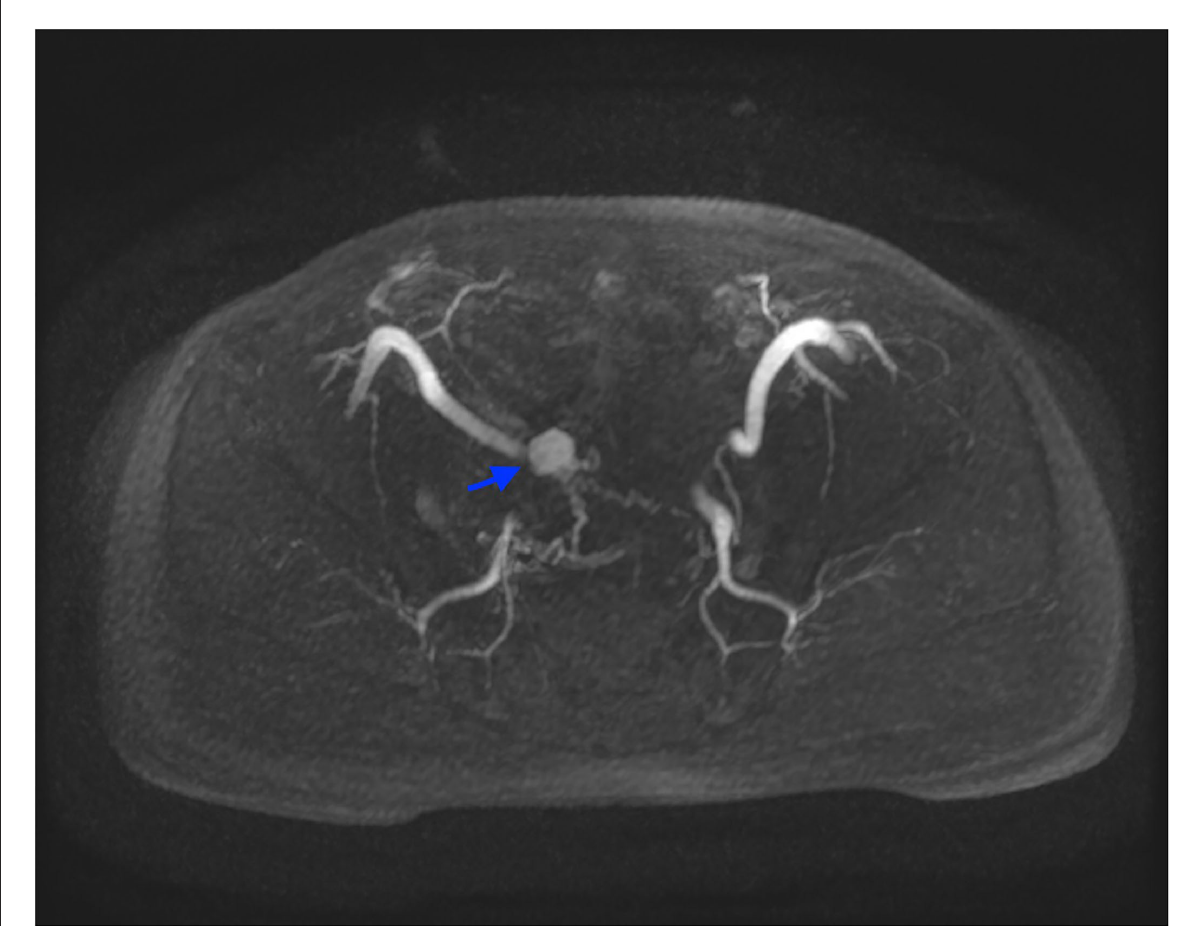
FIGURE2 MRI angiography, axial LAVA sequence acquired in arterial phase after administration of intravenous contrast media, with Maximum Intensity Projection reformatting. This image depicts the highly vascularized lesion and its feeding vessels (blue